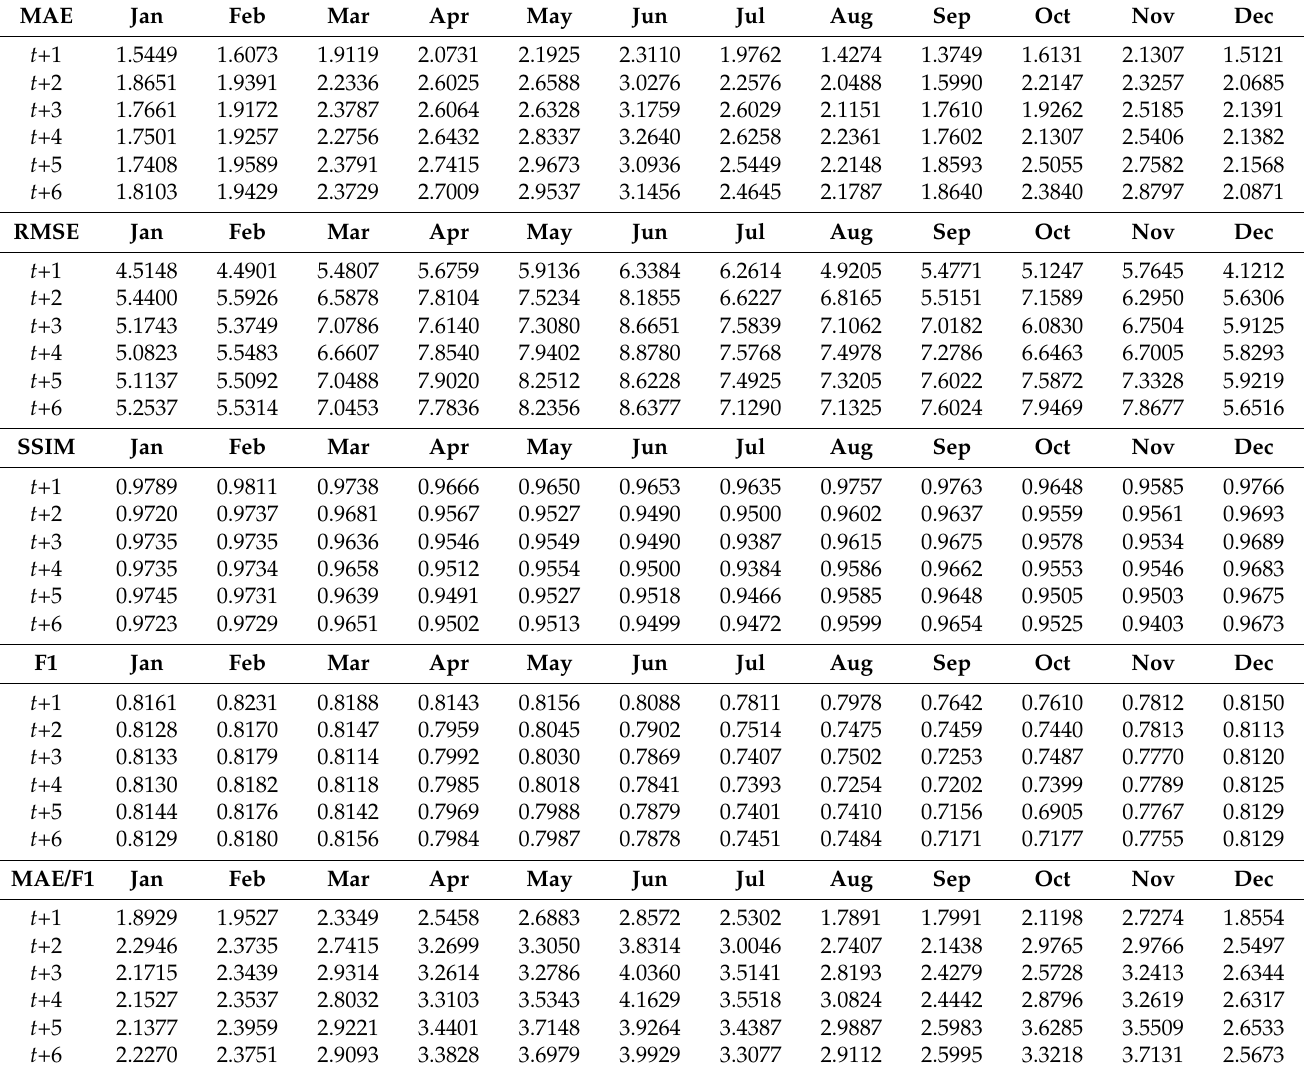
Table 6. Statistics of prediction errors according to lead-time and